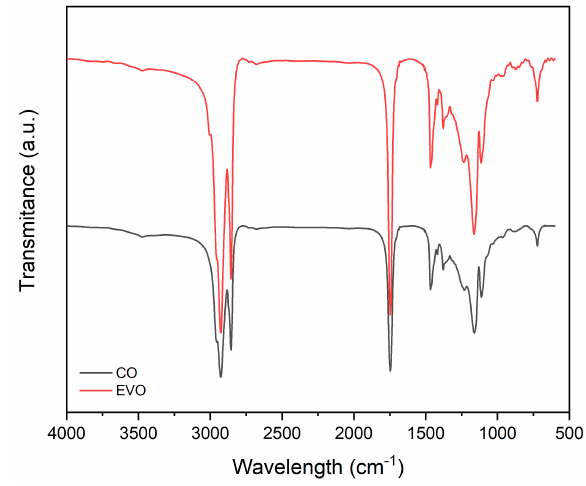
Figure 3. FTIR spectra of (black) coconut oil and (red) olive oil. Table 3. Functional groups and mode of vibration from FTIR spectra of the evaluated oils.